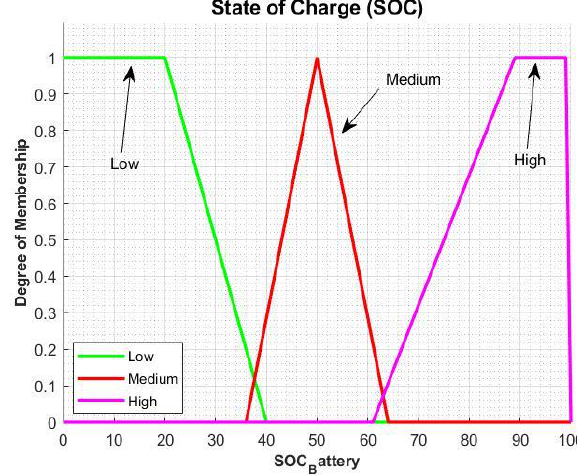
Figure 8. Fuzzy membership functions for SoC of storage.